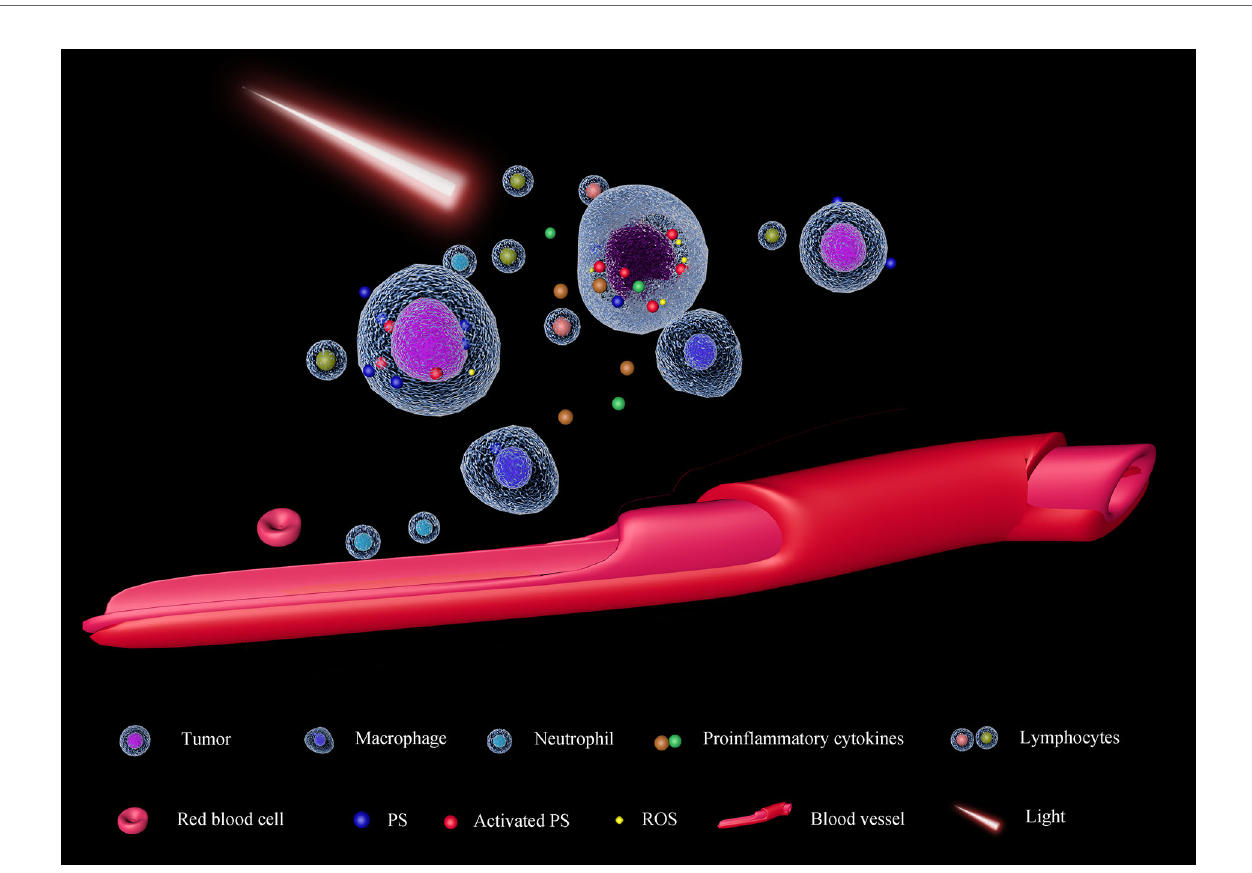
FIGURE 4 | Schematic diagram of PDT. The photosensitizer (PS) will be activated by light with an appropriate wavelength, causing the accumulation of ROS in the cells. Exceeded ROS damages tumor cells directly and epithelial cells of tumor-associated vessels. As the impairment of the tumor cell membrane, some pro- in fl ammatory cytokines will be released, facilitating the recruitment of immune cells in the tumor microenvironment (TME). On the other hand, as the tumor-associated vessels are also damaged, nutrients and oxygen supplements for the tumor will decrease; moreover, the neutrophils and macrophages can transport into the TME, suppressing tumor